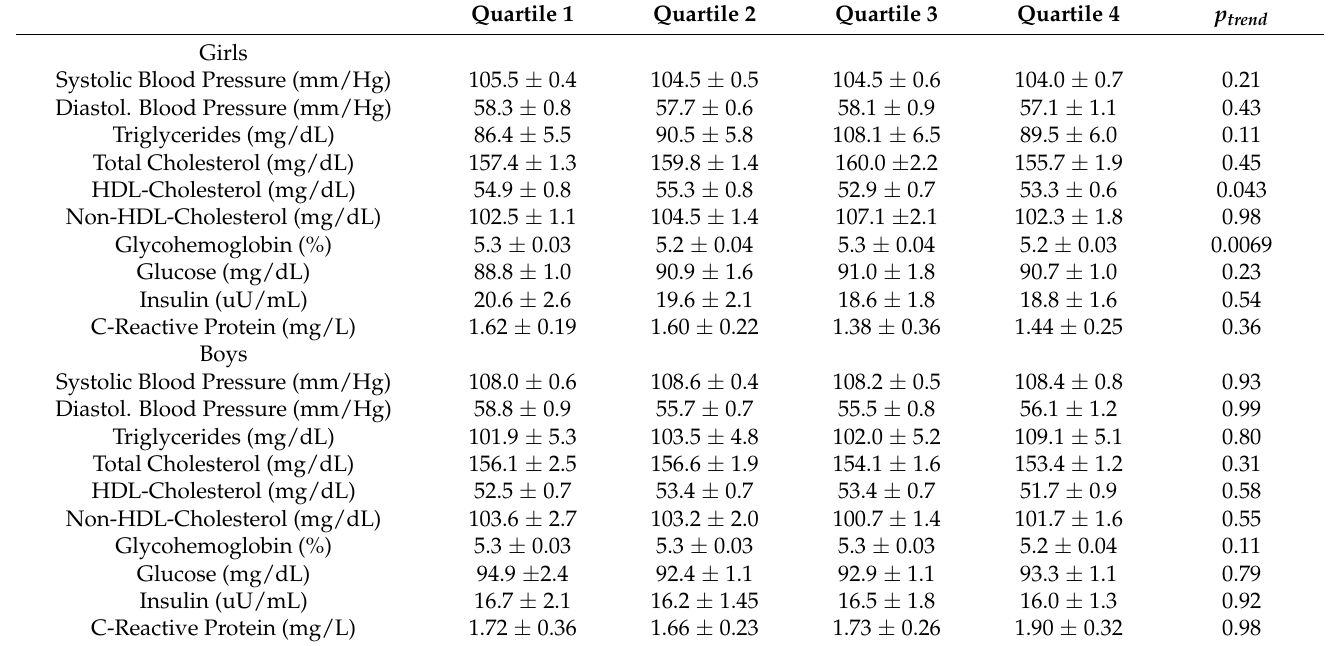
Mean values and standard errors obtained from survey-weighted multivariable linear regression models by the least squares means method; Model 1 adjusted for age and sex; Model 2 further adjusted for serum cotinine levels, BMI, waist circumference, height, education level of the household’s reference person, race/ethnicity, poverty-to-income ratio and fasting duration; analyses of BMI are not adjusted for waist circumference, and analyses of waist circumference are not adjusted for BMI; p values for linear trend are from linear regression models, with anthropometric factors or biomarker levels on the log2 scale as the dependent variable and plasma fluoride concentrations on the log2 scale as the independent variable; and * sample sizes smaller for the fol- lowing biomarkers: blood lipids: n = 3443; glucose and insulin: n = 2173; HbA1c: n = 2212; and C-reactive protein: n = 1823. Table A2. Adjusted mean levels of blood pressure and metabolic biomarkers across sex-specific quartiles of plasma fluoride among girls ( n = 1733) and boys ( n =